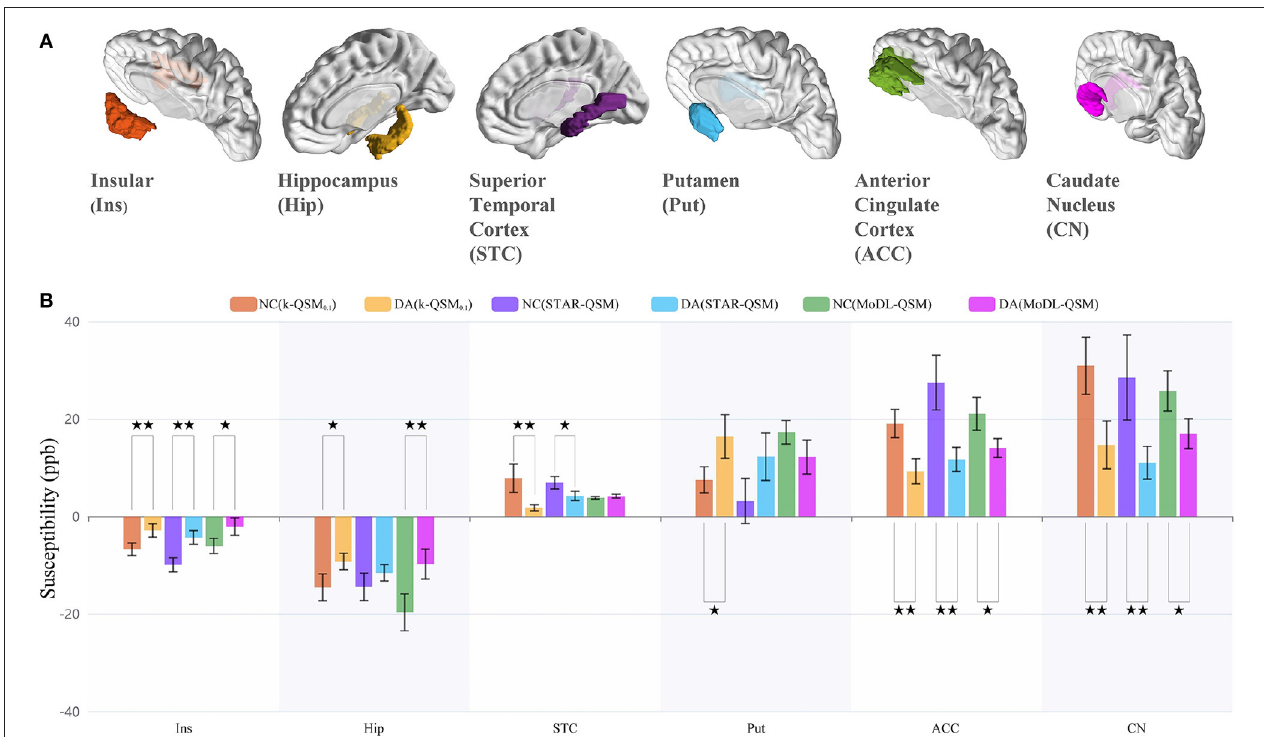
FIGURE 9 | ROI analysis of the results of 15 healthy normal controls (NC) and 15 drug addicts (DA) using the k-QSM, STAR-QSM, and MoDL-QSM methods. (A) The selected quantitative susceptibility mapping (QSM) segmented region of interests (ROIs). (B) Susceptibility values of the ROIs, presented as mean ± standard deviation with ⋆⋆ denoting extremely significant ( p < 0.01) and ⋆ sufficiently significant (0.01 ≤ p < 0.05) difference between mean values of the groups. 51.62% shrinkage ( p = 0.0014) in the ACC, 52.62%